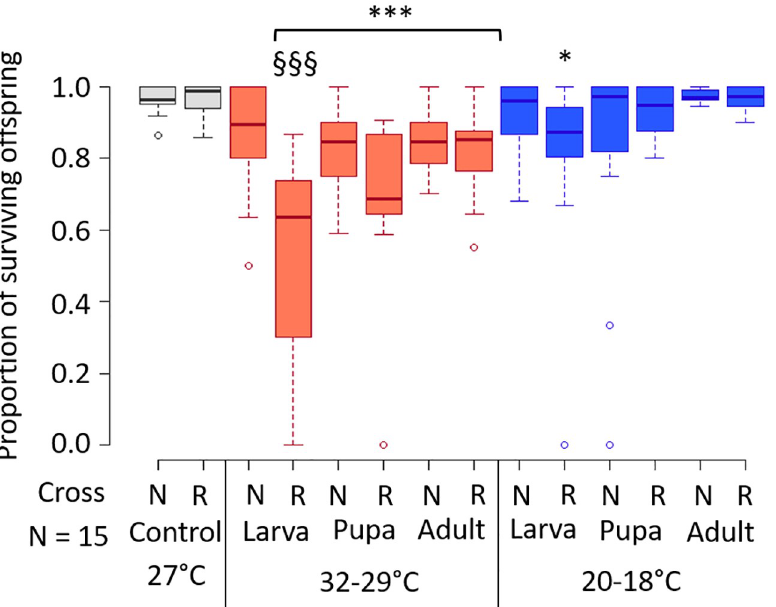
Fig 3. Proportion of surviving offspring (developed pupae) generated from crosses involving female wasps exposed to different temperatures. Color of bars denotes temperature range (grey = 27˚C, red = 32–29˚C, blue = 20– 17˚C). Treatments are also separated by the stage at which temperature exposure began. N = control cross: C+ female x C- male. R = rescue cross: C+ female x C+ male. Asterisks denote significant differences compared to respective crosses at 27C. § denotes significant differences to the N cross within that temperature treatment. N = 15 females for each treatment, with the mean number of offspring per female = 9.25.